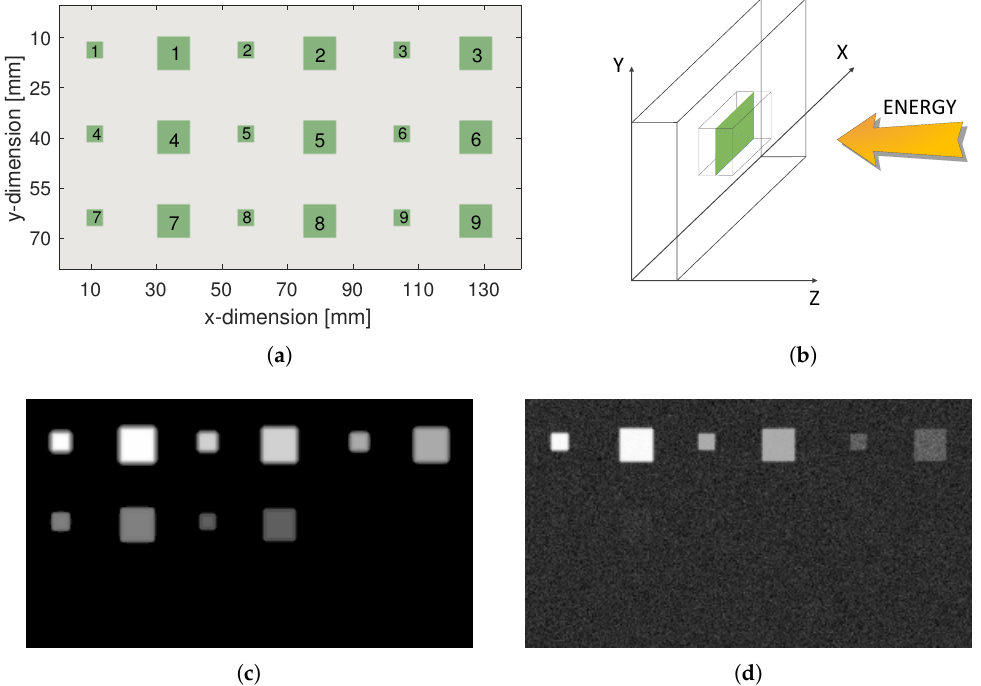
Figure 4. Modeled NDT thermographic inspections: ( a ) position of defects with depth indicated numerically [mm], ( b ) thermal stimulation considered in the model, ( c ) scaled temperature values obtained with the theoretical model in absence of noise after 5 s in the heating process , ( d ) scaled temperature values obtained with the theoretical model in the presence of noise after 5 s in the heating